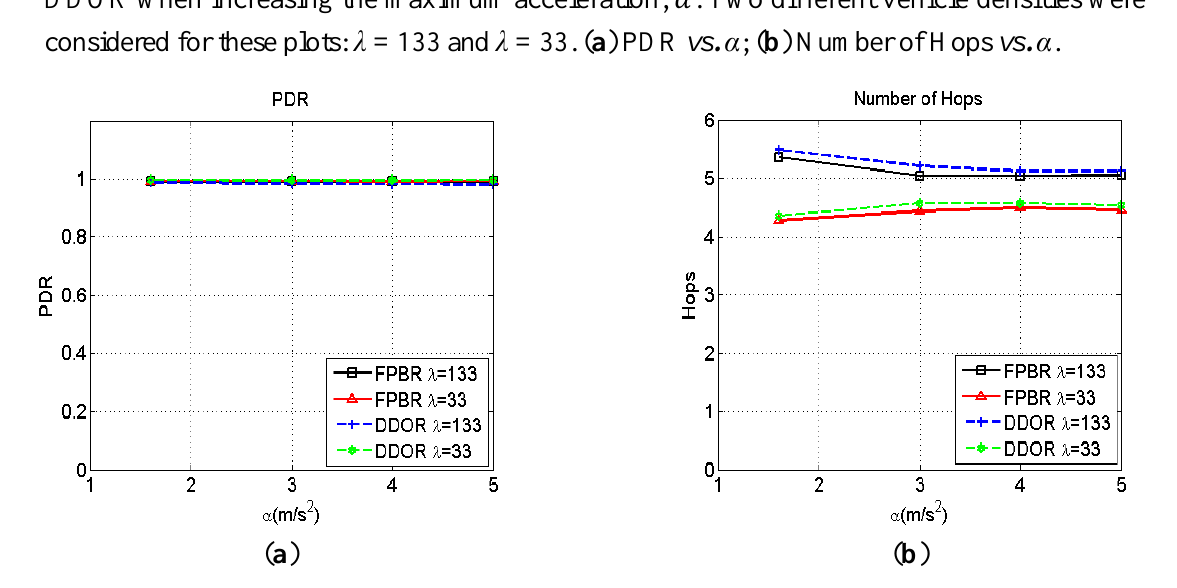
Figure 7. Packet delivery ratio (PDR) and number of hops (NH) obtained with FPBR and DDOR when increasing the maximum acceleration, . Two different vehicle densities were